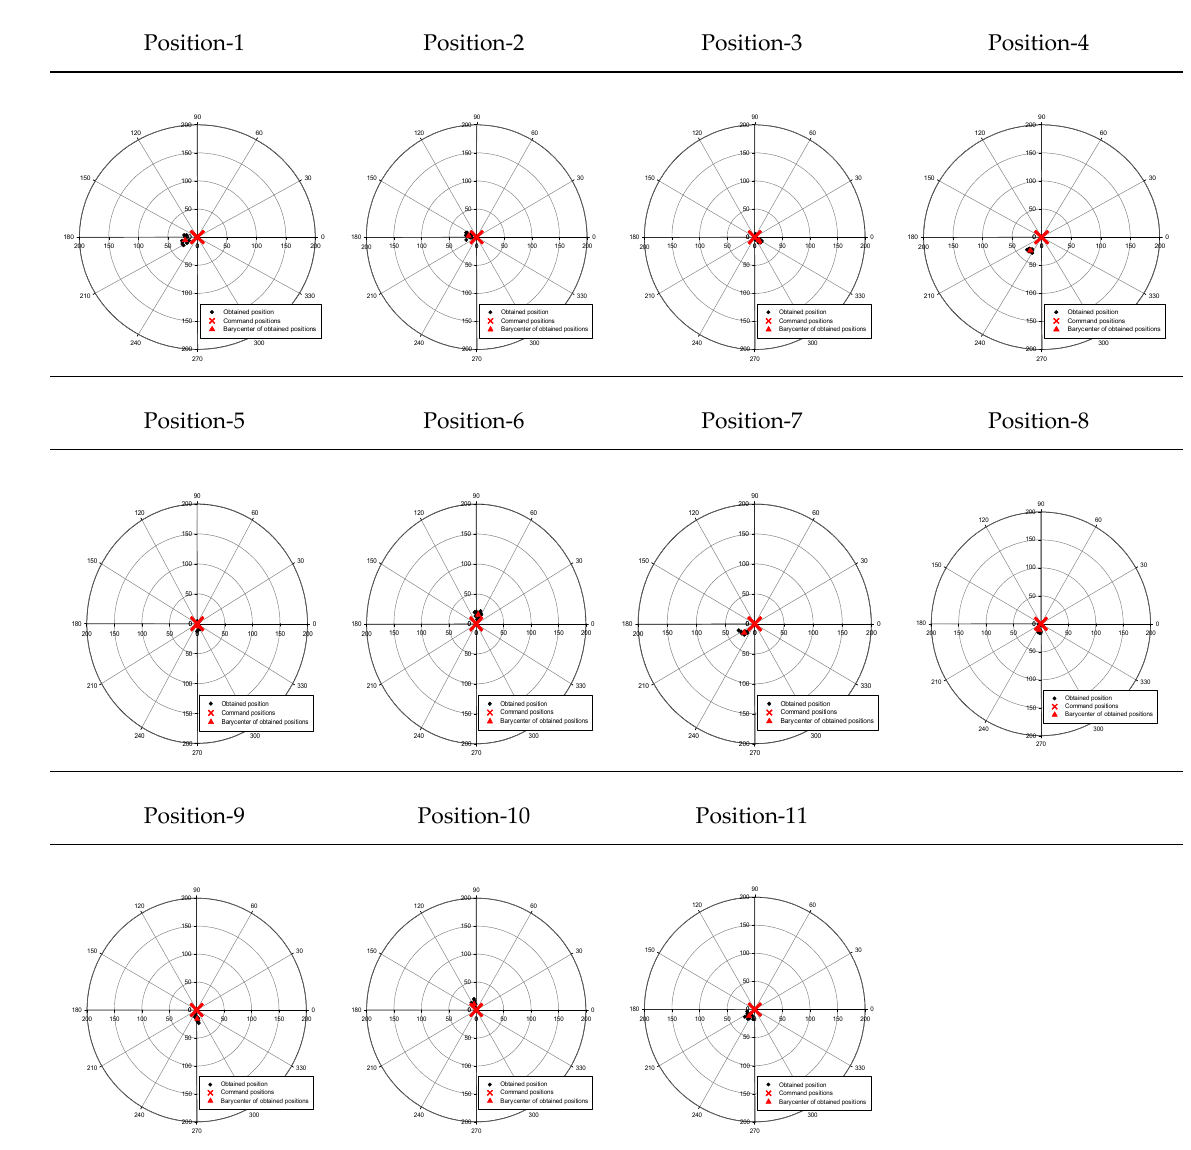
Figure 9. The polar plots of Ac and Rp . Table 5. Ac and Rp results.